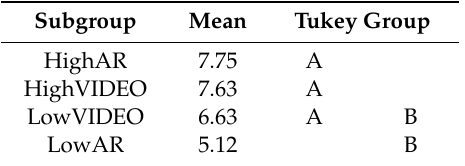
Table 5. Tukey groupings for number of correct marks.